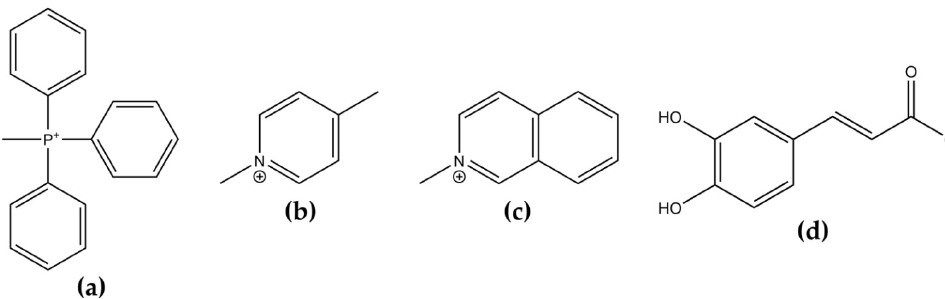
Figure 1. Chemical structures of ( a ) Triphenylphosphonium; ( b ) 4-Methylpyridinium or 4-picolinium; ( c ) Isoquinolinium; and ( d ) Caffeic acid.